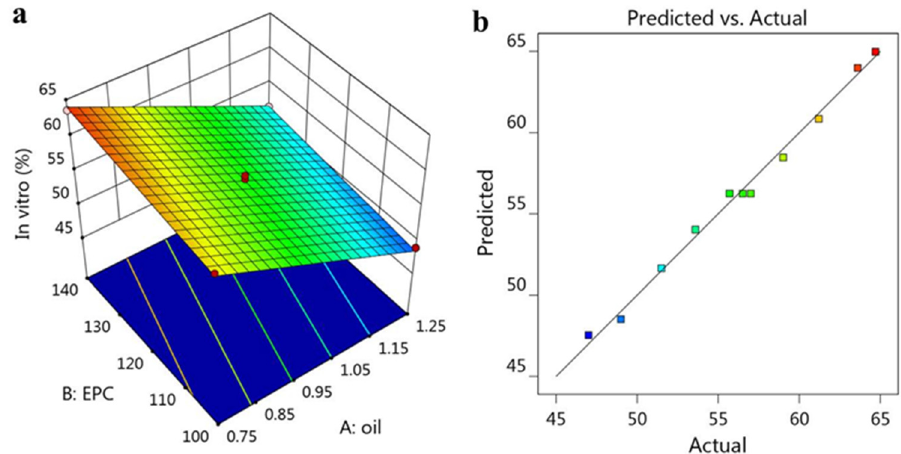
Figure 2. ( a ) 3D-response surface plot and ( b ) linear correlation plot between predicted versus actual